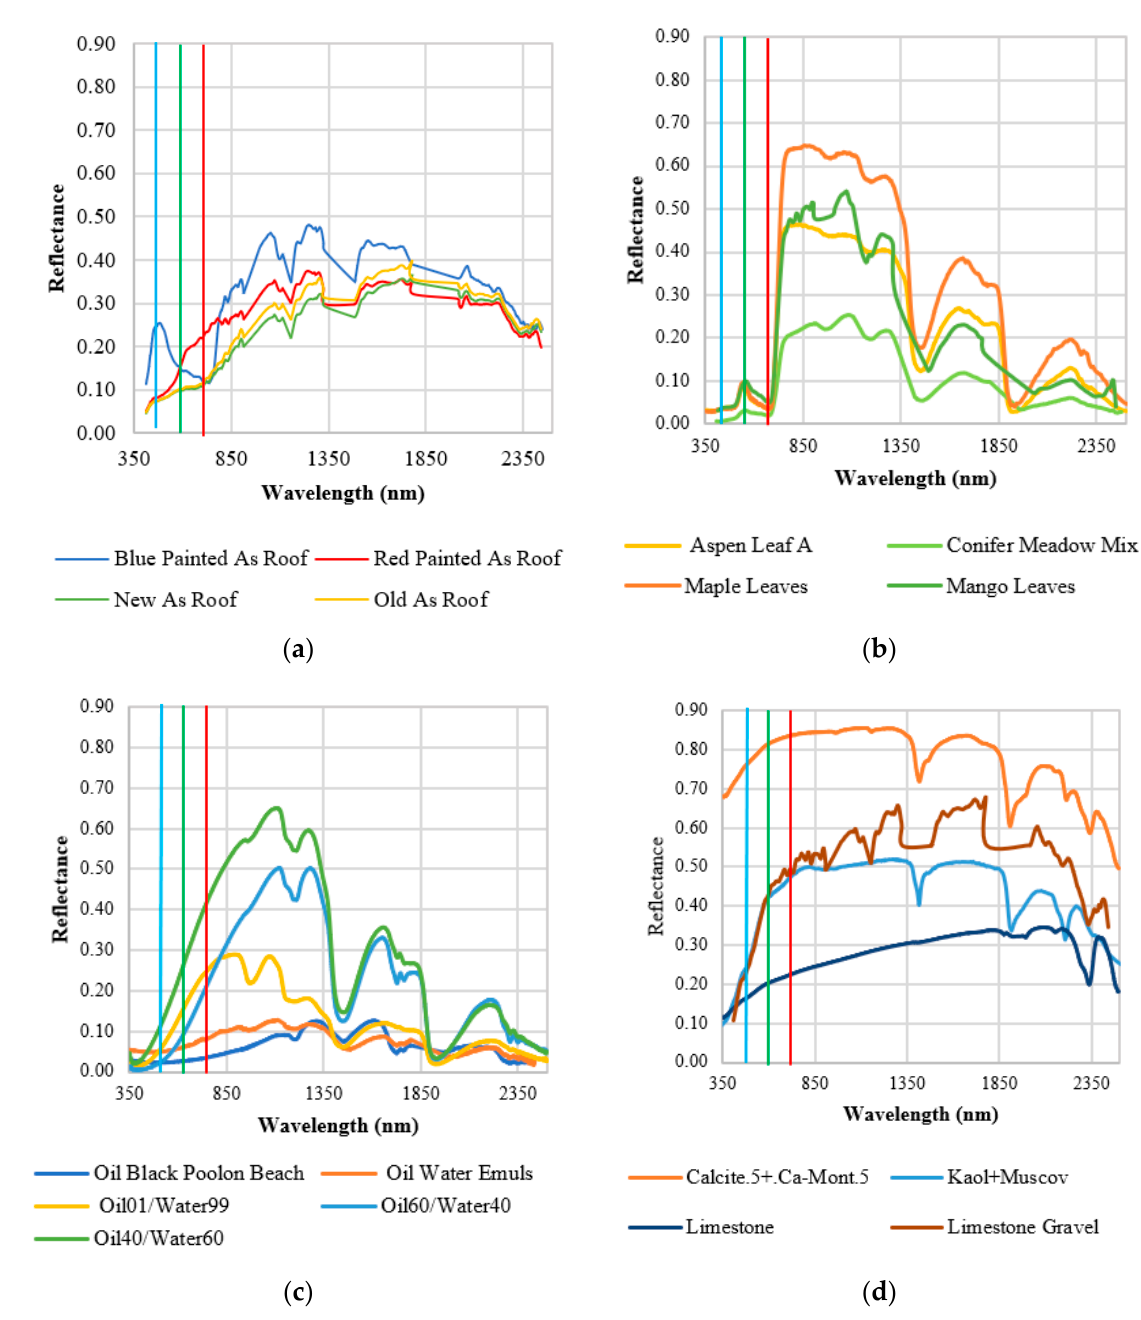
Figure 5. Spectral signatures of some materials within the categories: ( a ) asbestos, ( b ) oil and gas, ( c ) vegetation, and ( d ) soil. Vertical lines represent blue, green and red area of the spectrum. Reflectance can vary from 0 to 1.